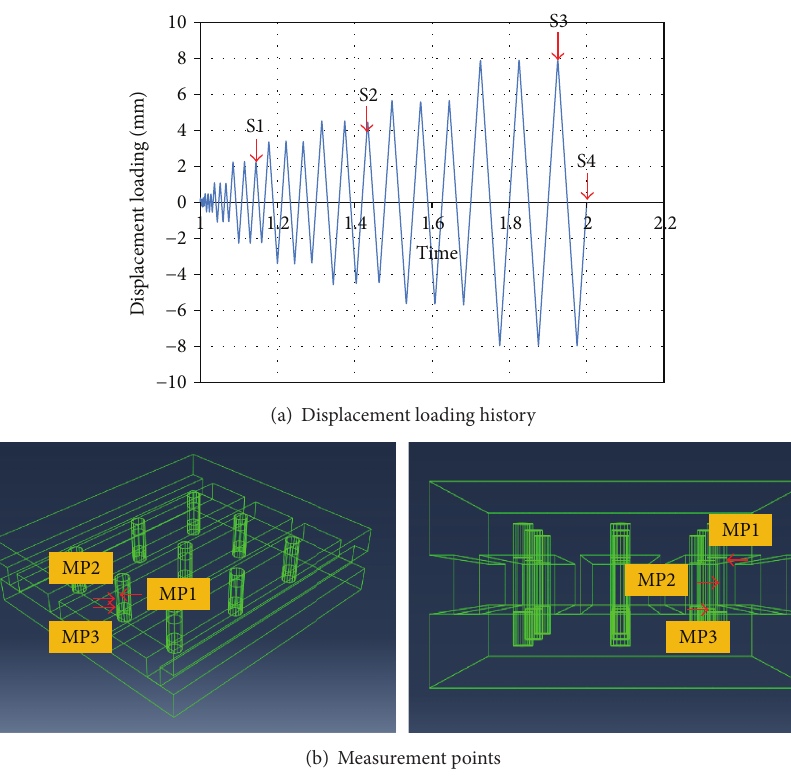
Figure 8: Displacement loading history and measurement points for data